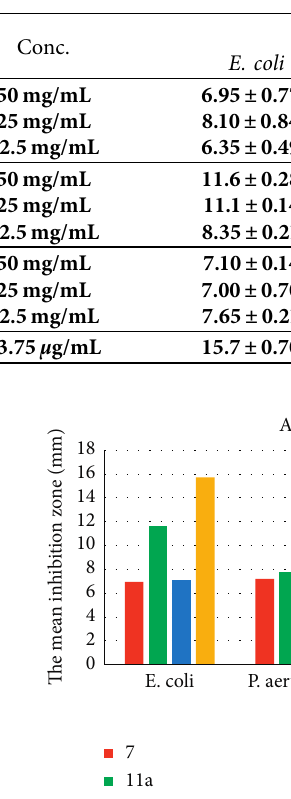
Table 1: Zone of bacterial growth inhibition diameter (mm).